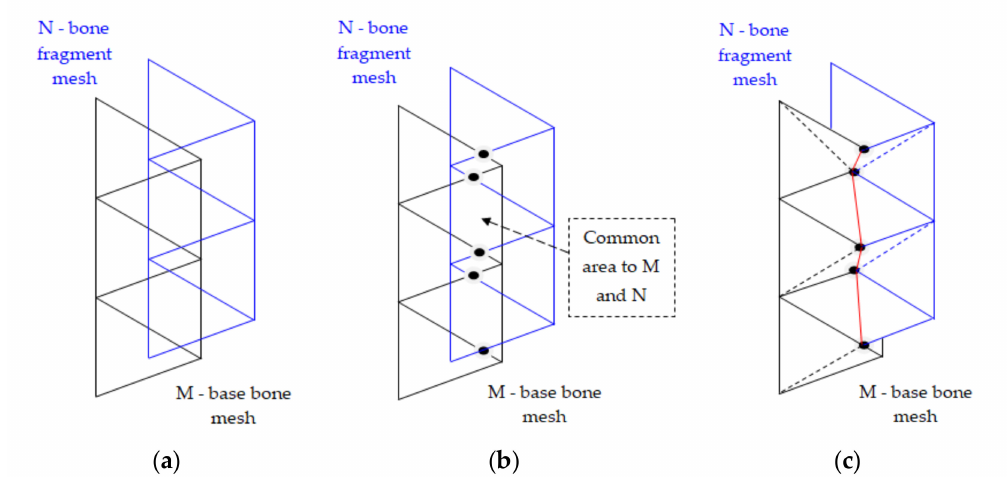
Figure 6. The networks M and N are cut at the common boundary: ( a ) the intersection between the edges of the M and N meshes allows determination of triangle intersection points; ( b ) portions of triangles on the M and N meshes are removed; ( c ) both networks are limited at the points of intersection and new triangles are